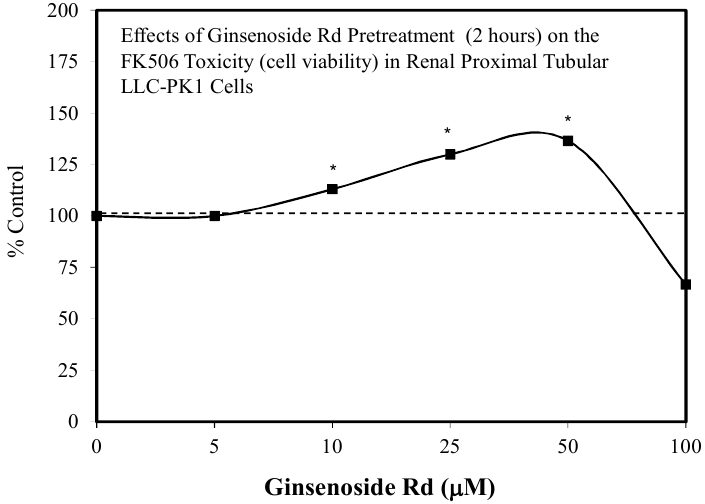
Figure 31. Effects of ginsenoside Rd pretreatment (2 h) on the FK506 toxicity (cell viability) in renal proximal tubular LLC-PK1 cells (Source: [110]). Each * represent statistical significance for a data point.